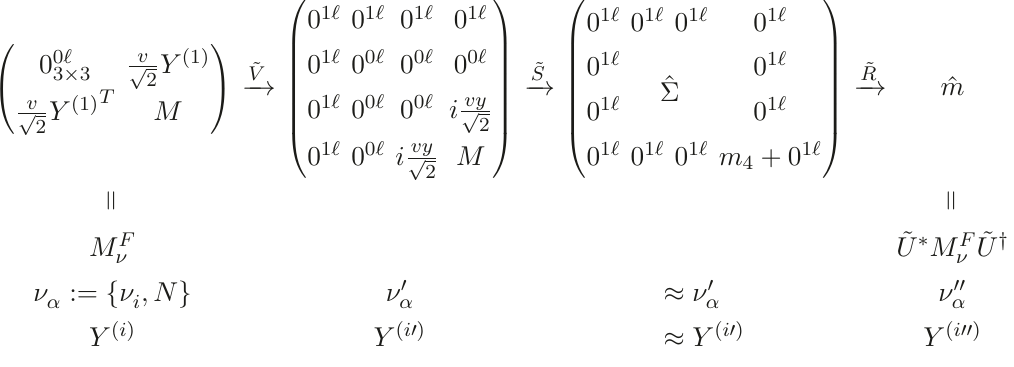
Figure 1. A sequence of rotations for neutrino mass matrix M F used in the paper. We denote an expression that is zero exactly at tree-level by 0 0 ℓ . With 0 1 ℓ we mean an approximated one-loop zero, where terms proportional to y 2 neglected. The matrix ˆΣ contains non-vanishing expressions for the processes ν ′ level, which are not further suppressed by y 2 or m 3